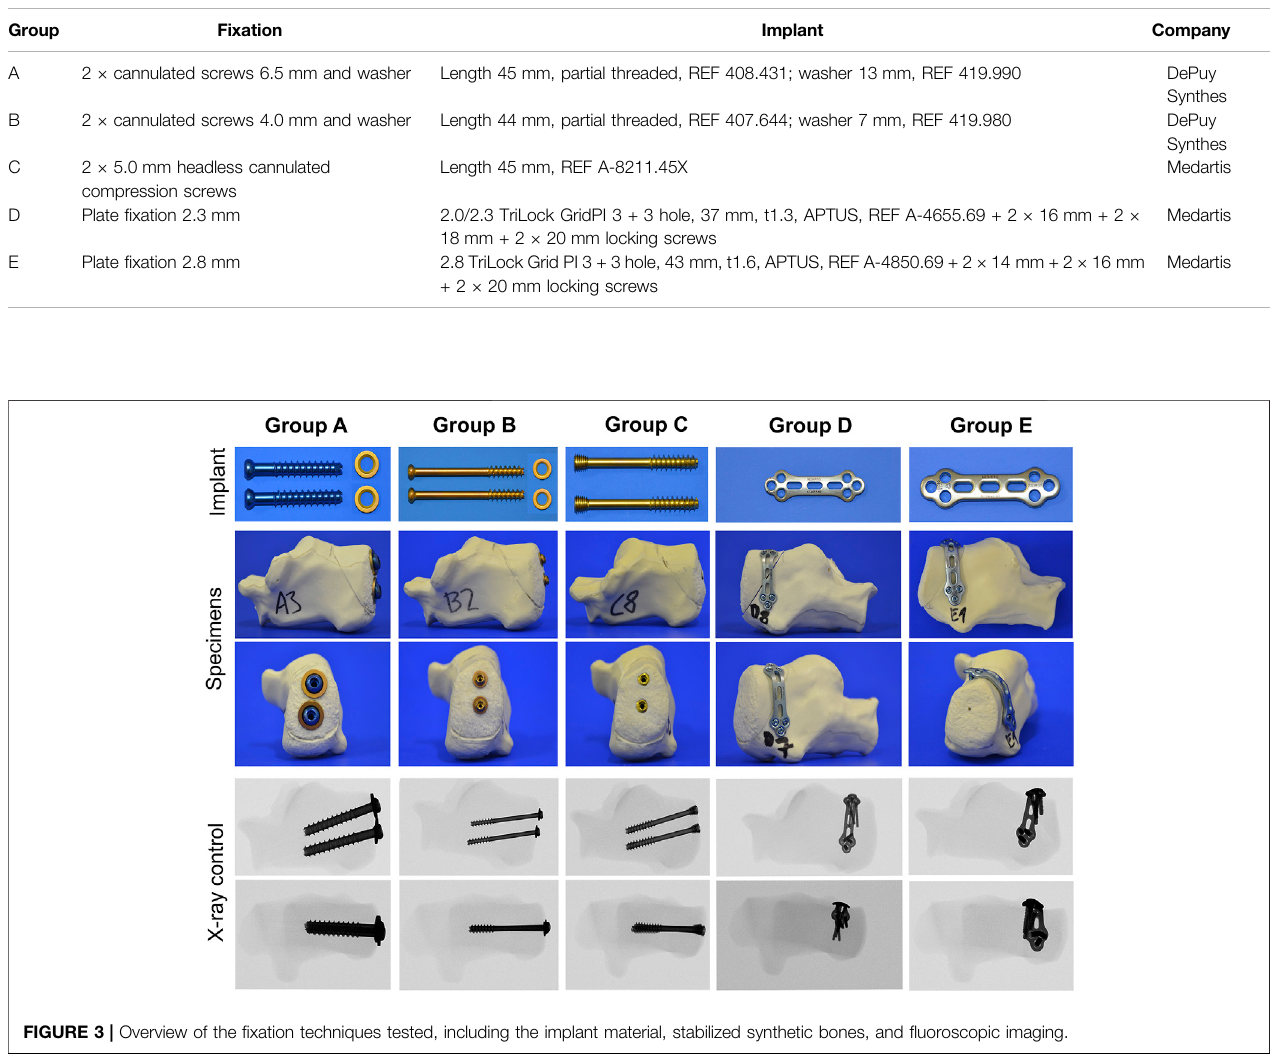
Frontiers in Bioengineering and Biotechnology |